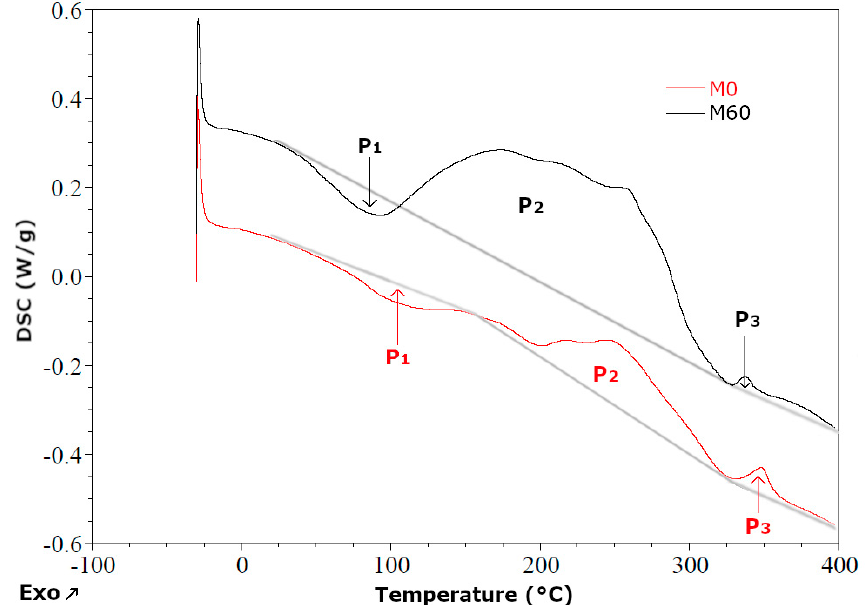
Figure 9. Differential scanning calorimetry (DSC) curves of reference foam (M0) and modified foam containing 60 wt.% of bio-filler (M60).